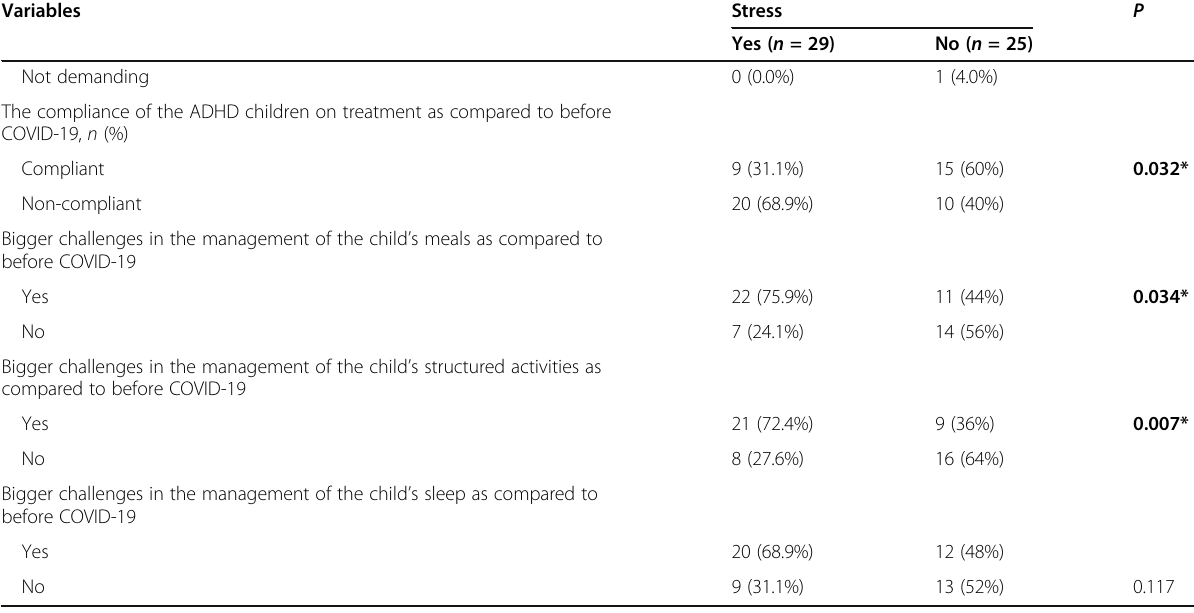
Table 5 Association between stress and other characteristics in mothers of ADHD children (Continued) Variables Stress P